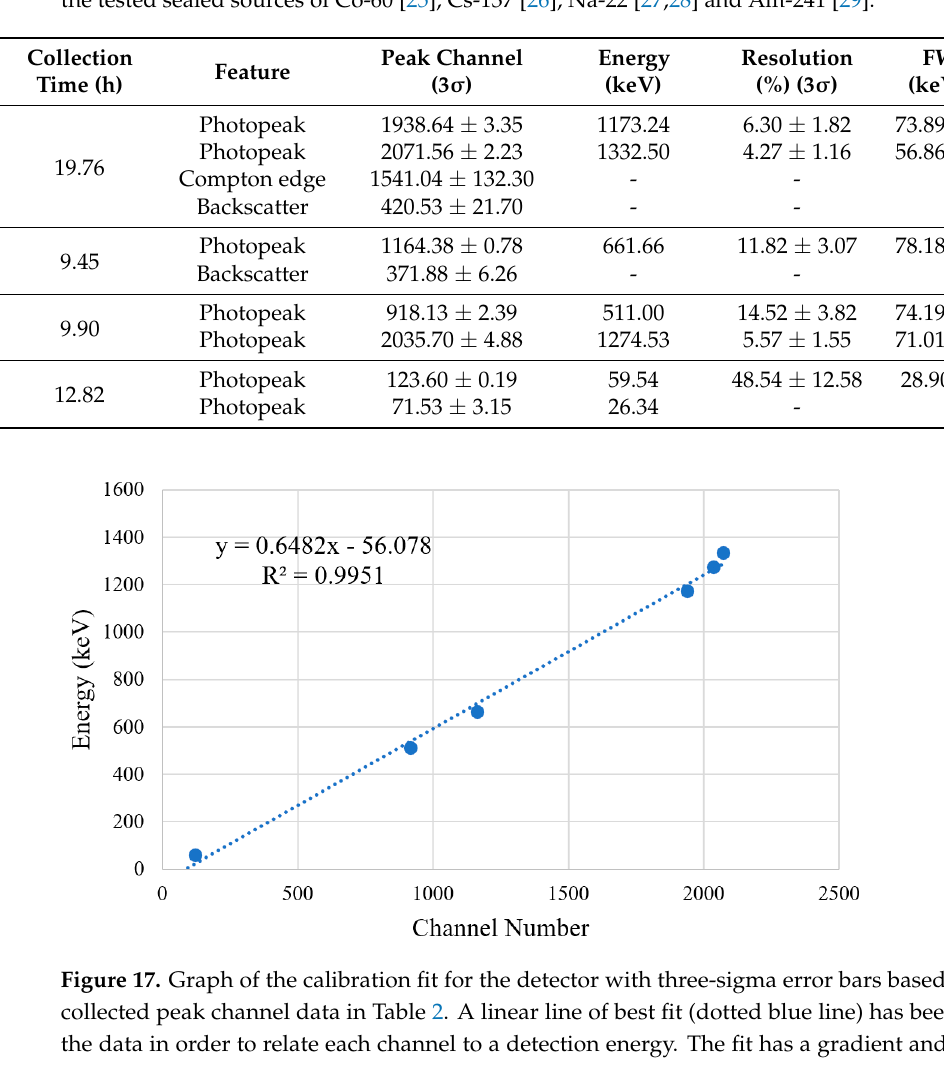
Table 2. Calibration table of peak channel detected for photopeak, backscatter and Compton edge of the tested sealed sources of Co-60 [25], Cs-137 [26], Na-22 [27,28] and Am-241 [29].